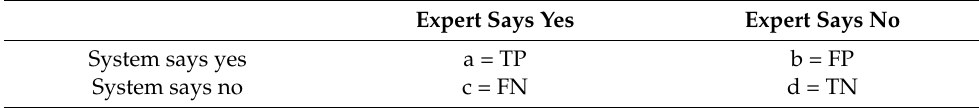
Table 2. Definition of Metric Equations.